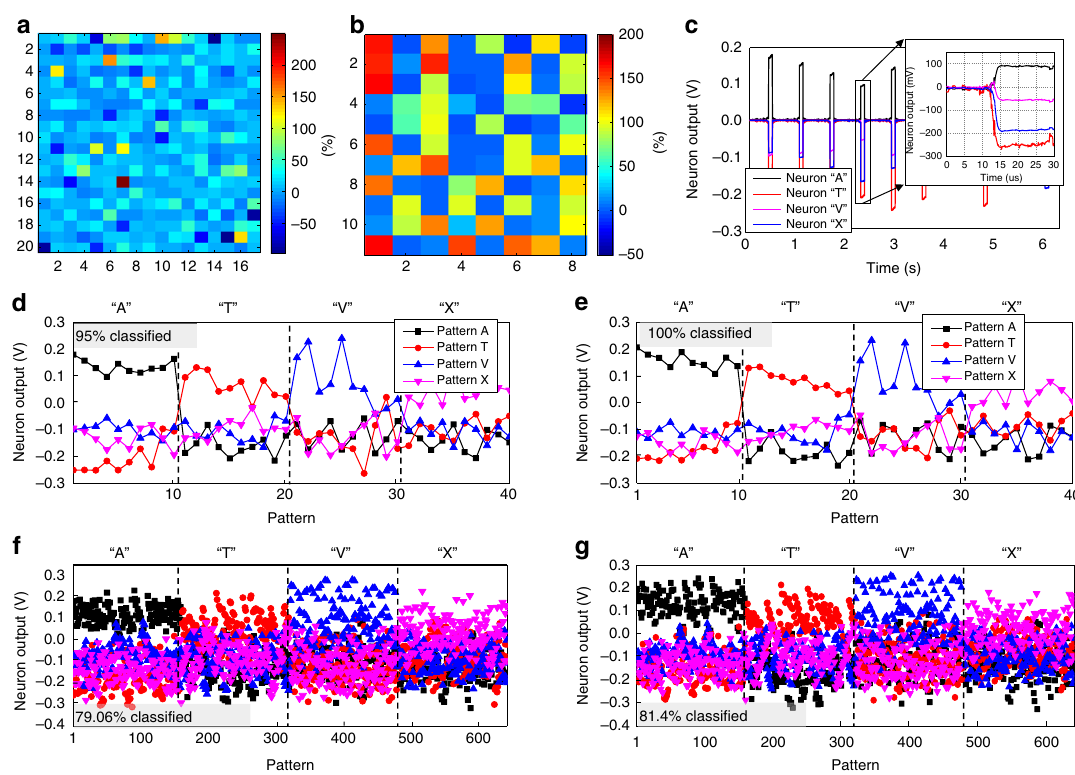
Fig. 5 Ex-situ training experimental results. a , b The normalized difference between the target and the actual conductances after tuning in a the fi rst and b the second layer of the network for the hardware-oblivious training approach; c Time response of the trained network for 6 different input patterns, in particular showing less than 5 μ s propagation delay. Perceptron output voltage for d , f hardware-oblivious and e , g hardware-aware ex-situ training approaches, with d - g panels showing measured results for training/test